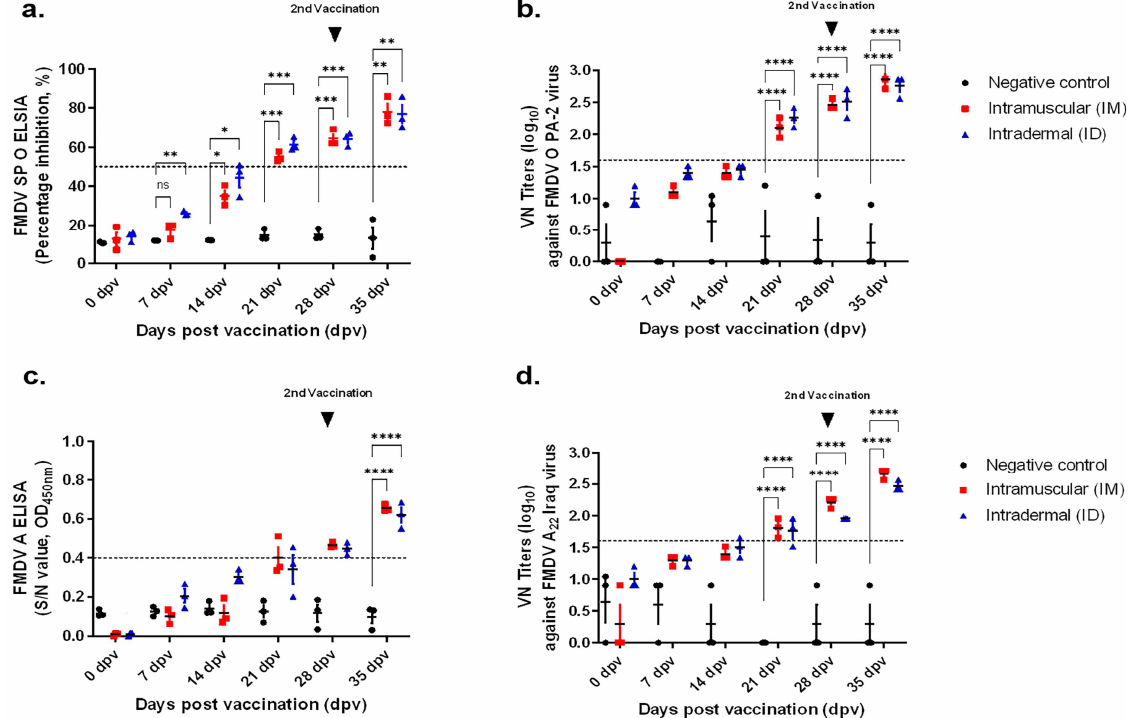
Figure 2. Comparison of serological response after vaccination of guinea pigs with ID and IM vaccine. The test vaccine was administered to guinea pigs at one-tenth dose of O PA-2 + A22 Iraq antigen for pig use, ISA207 (oil-based emulsion, 50%, W/O/W), 10% Al(OH)3, and 1% Saponin. The negative control group was administered the test without vaccine. The IM group was inoculated with 0.2 mL/dose of vaccine and ID group was inoculated with 0.05 mL/dose of vaccine. Serum sampled from guinea pigs at 0, 7, 14, 21, 28, and 35 dpv was analyzed via SP antibody ELISA and VN assay. ( a ) Percentage inhibition (PI) value of FMDV type O SP ELISA in individuals (The dashed lines are positive value.). ( b ) VN titers against the FMDV O PA 2 strain. ( c ) Percentage inhibition (PI) value of FMDV type A SP ELISA in individuals (The dashed lines are positive value.). ( d ) VN titers against FMDV A22 Iraq strain. The do(cid:308)ed lines in SP-ELISA results indicate 50% inhibition, the positive threshold in the test. The do(cid:308)ed lines in VN test show 1.65 log VN titers. IM: intramuscular injection; ID: intradermal injection; the datasheets are the mean ± SEM; statistical analyses were performed using two-way ANOVA; ns; *, p < 0.05; **, p < 0.01; ***, p < 0.001; and ****, p < 0.0001. In swine vaccination experiment, the IM and ID groups showed positive values after 21 dpv in both type O and type A SP-ELISA (Figure 3a,c). This pa(cid:308)ern was similar to that observed in the guinea pig experiment, and the positivity rate was 70–80% at the end of the experiment. In swine, the VN titer was >1:30 in the ID group at 7 dpv (the initial stage of vaccination; Figure 3b,d). However, both groups (IM and ID) showed similar immuno- genicity after 21 dpv. At the end of the experiment, the VN titers were >1:300 in both groups.